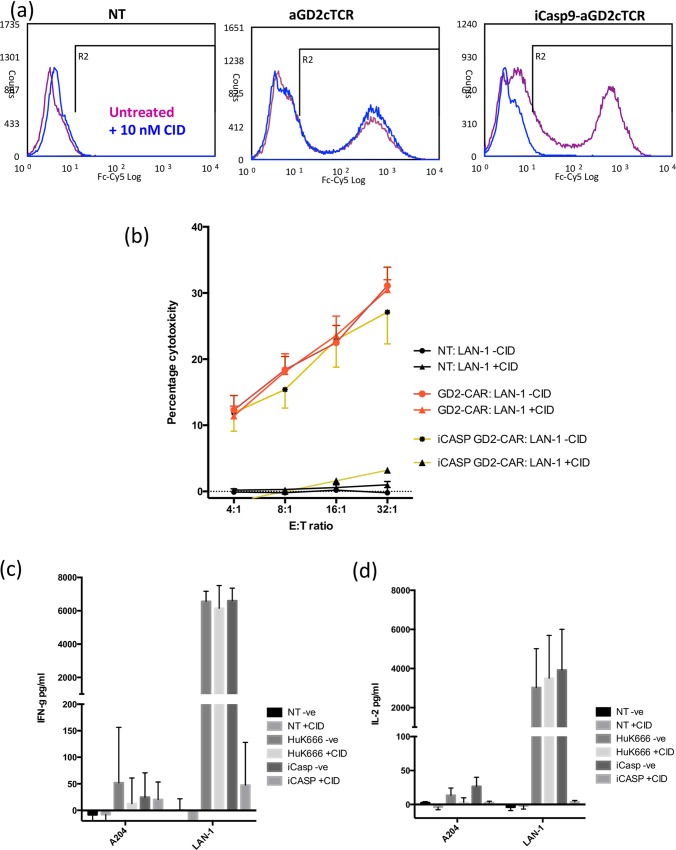
Consequence and function of iCasp9.The SAR codon-optimized cassette was taken further and compared with the original cassette without iCasp9. (a) Expression of the CAR was unchanged. Depletion is shown by facs after addition of CID. The function of cassettes with and without iCasp9 were assessed by (b) Killing (c) IFN-γ release and (d) IL-2 release. Data shown as means +/-SEM from 4 independent experiments with different donors.